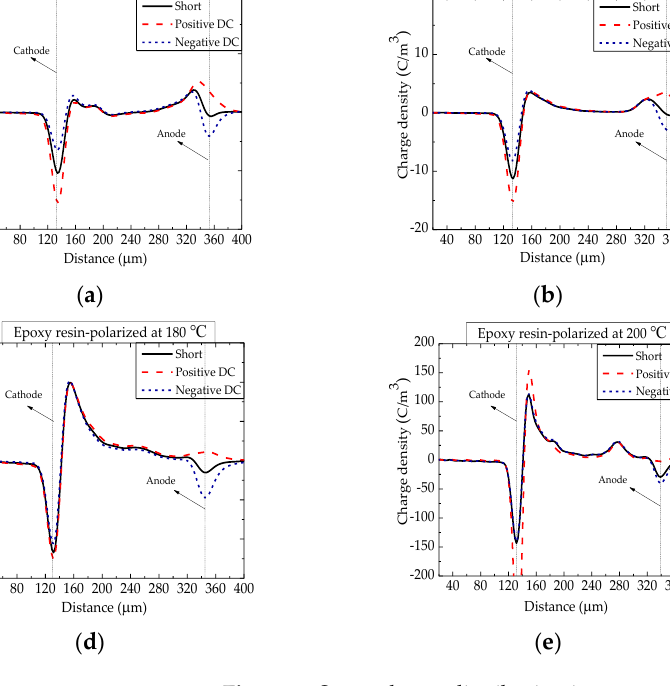
Figure 2. Space charge distribution in epoxy resin polarized at temperatures between 40 and 100 °C. ( a ) 40 °C; ( b ) 60 °C; ( c ) 80 °C and ( d ) 100 °C. The space charge distributions in EP polarized at temperatures of 120, 140, 160, 180 and 200 °C are shown in Figure 3. Except for hole and electron injection, there was heter- ogeneous aggregation around the cathode with temperature, which was due to the migra- tion and accumulation of mobile ions produced by the ionization of impurities. At this temperature range, the homopolar charge injected by the electrode is gradually covered up, and the impurity charge plays a dominant in space charge behavior. The maximum heterocharge density was 150 C/m 3 .